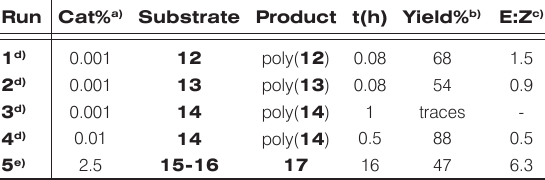
D (A) and in C F (B) monitored 6 6 6 6